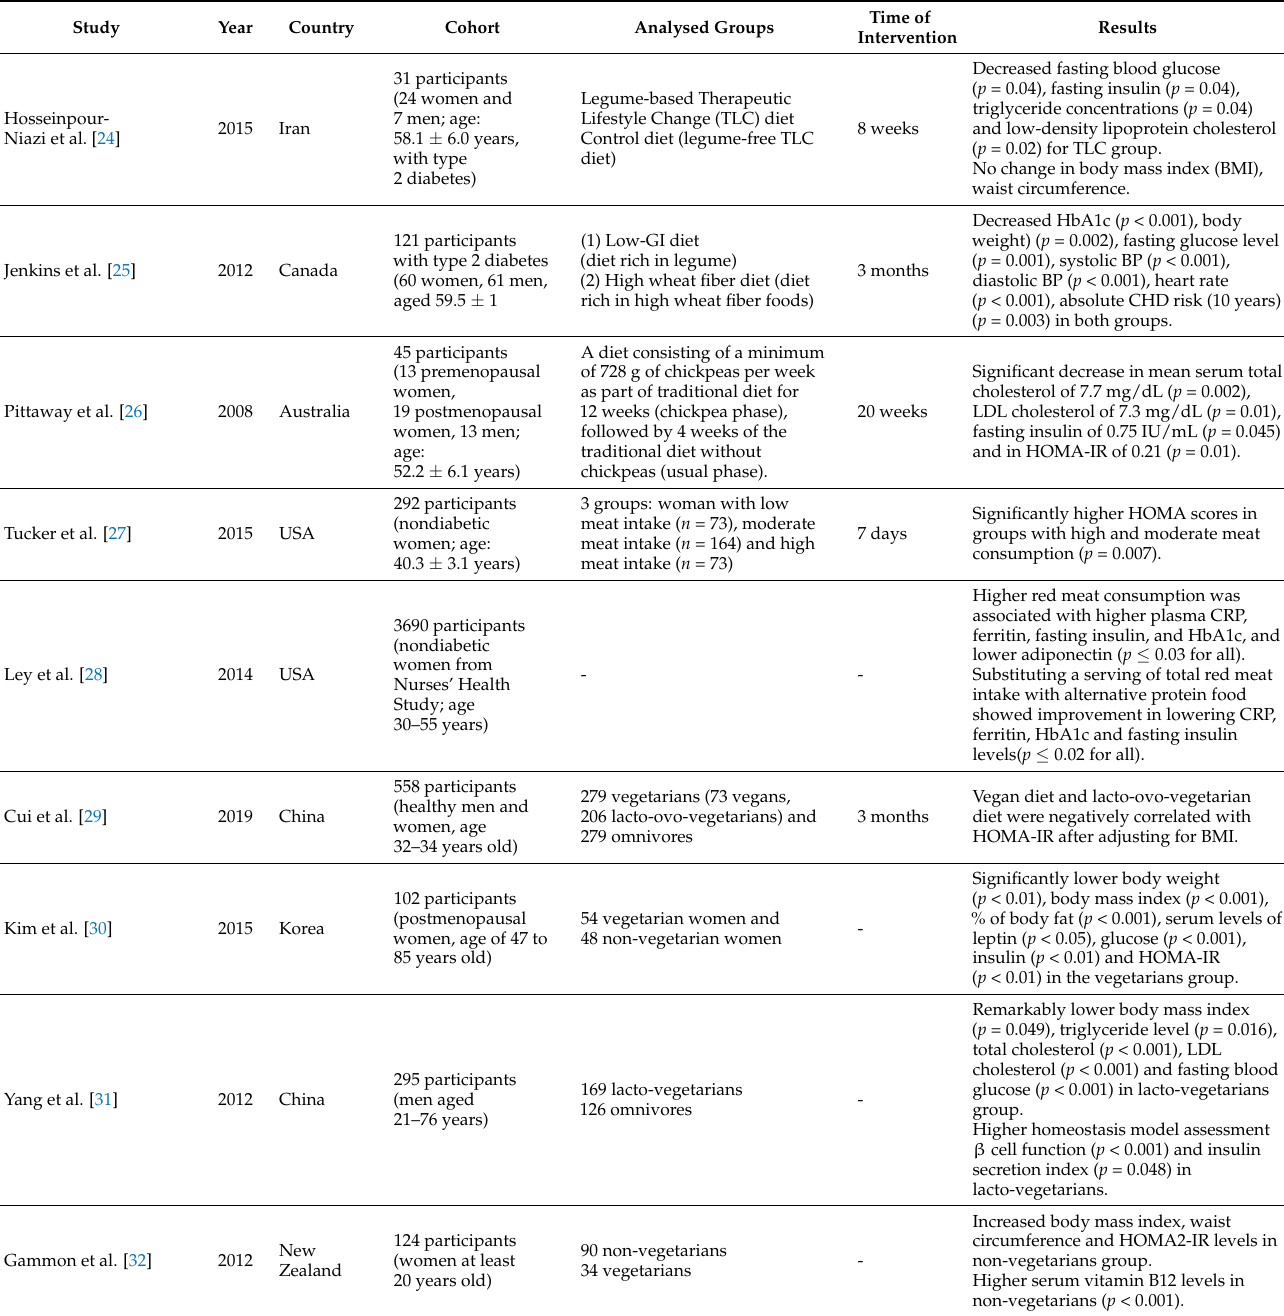
Table 2. The influence of a vegetarian diet on insulin